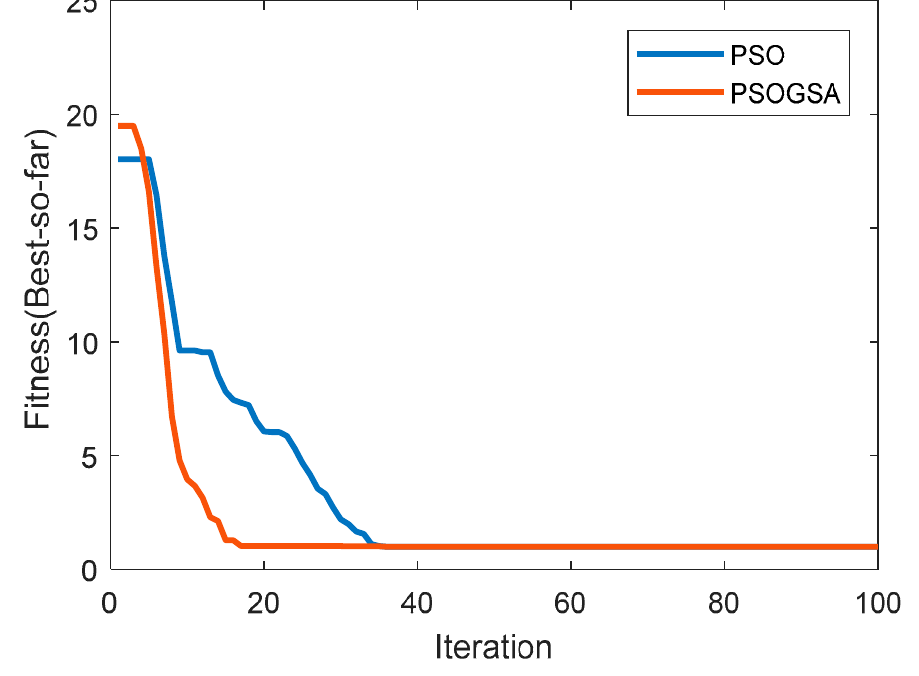
Figure 5. Convergence of algorithms (PSO–PSOGSA).